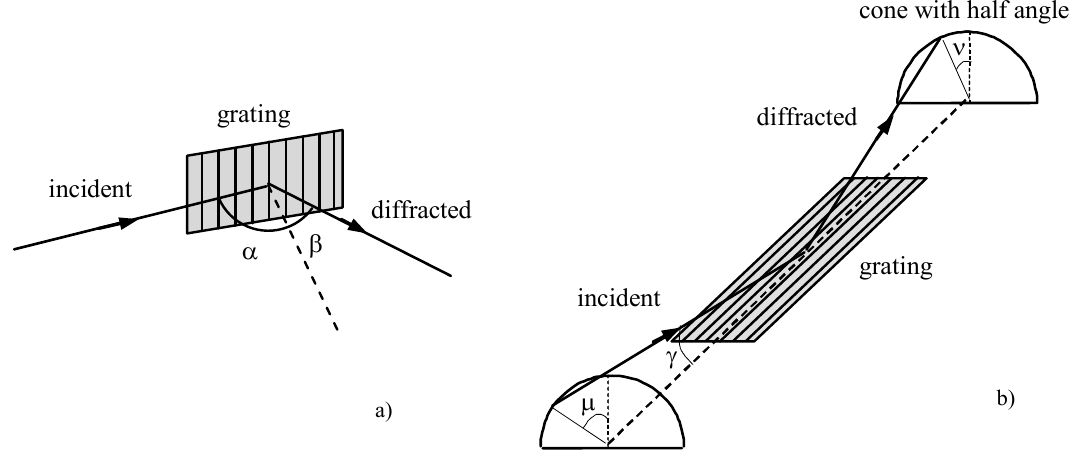
Figure 1. The grating geometry: ( a ) classical-diffraction mount (CDM); ( b ) off-plane mount